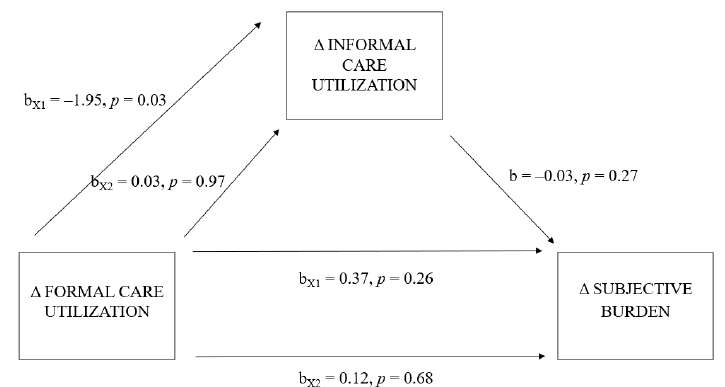
Figure 2. Model of shifts in formal care utilization as a predictor of change in subjective burden, mediated by shifts in informal care utilization. Note. Δ = difference between T0 and T1 .